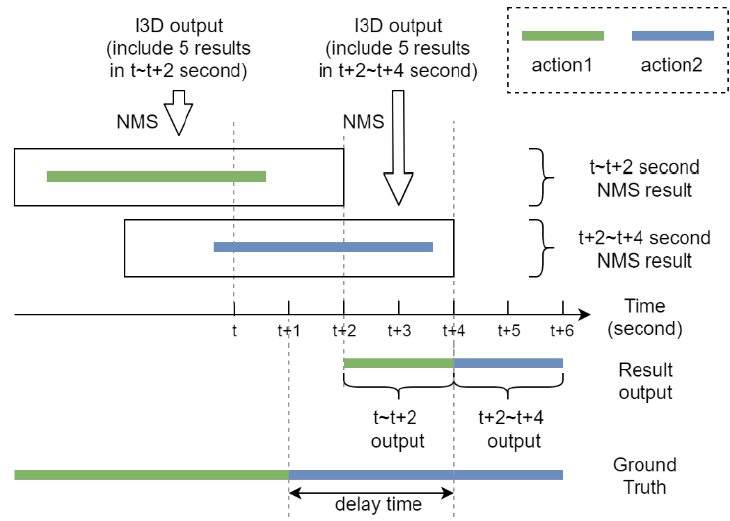
Figure 8. One-dimensional nonmaximum suppression (NMS) is used to derive the final recognition results.